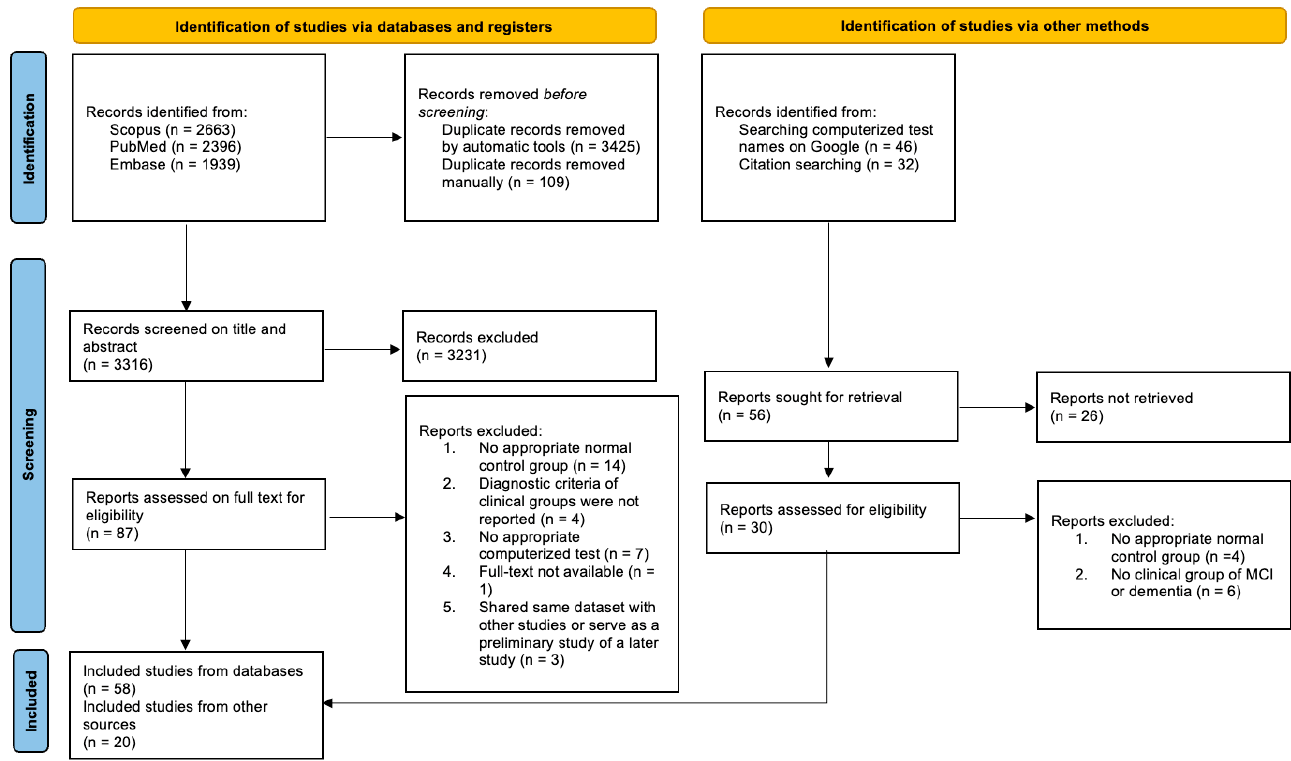
Figure 1. PRISMA flow diagram of study selection process.